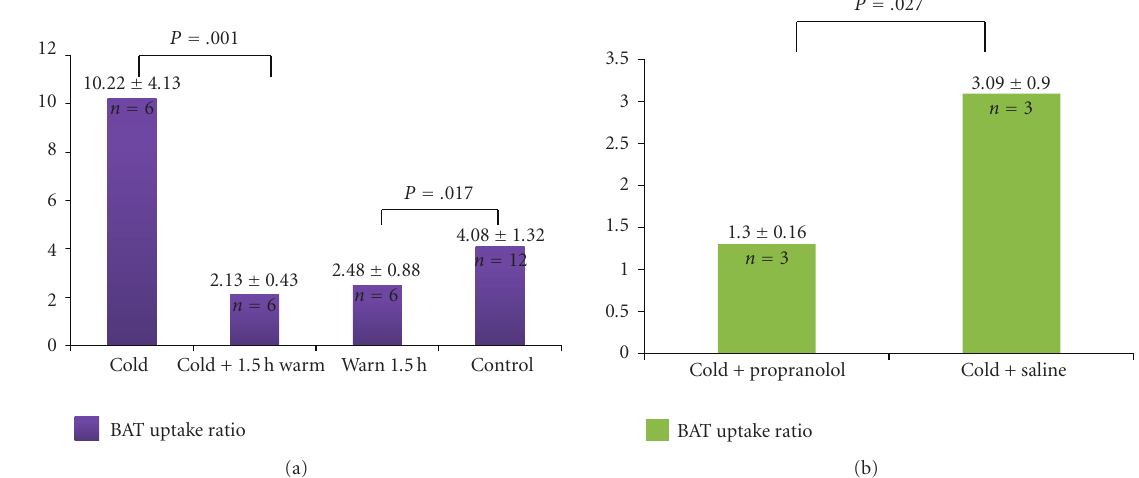
Figure 3: Comparison of the e ff ects of warming and propranolol to inhibit interscapular BAT in mice. (a) BAT FDG uptake ratio under warm intervention. Warming could significantly decrease BAT metabolism in mice with or without cold pre-exposure ( P = . 001 and . 017, resp.). (b) BAT FDG uptake ratio under propranolol intervention. Propranololcould significantly decrease BAT activity in cold pre-exposure mice ( P = .